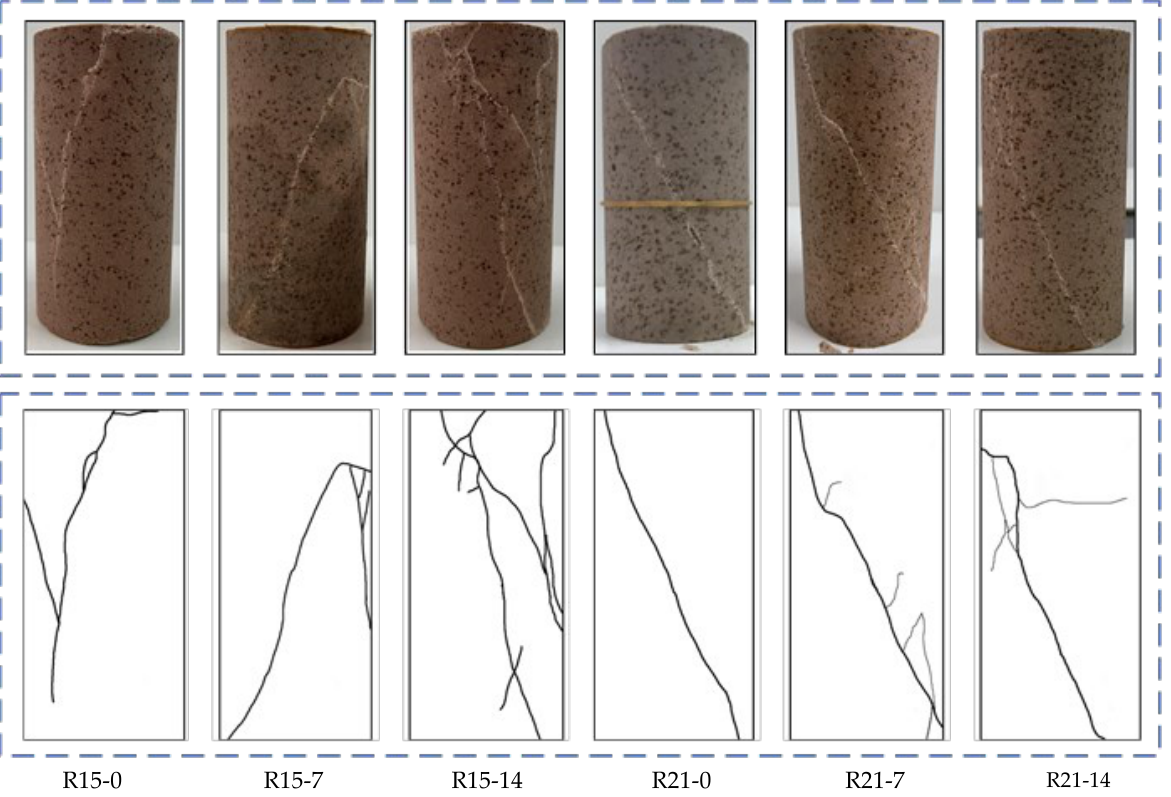
Figure 6. Creep damage characteristics of the unloaded sample under different conditions .